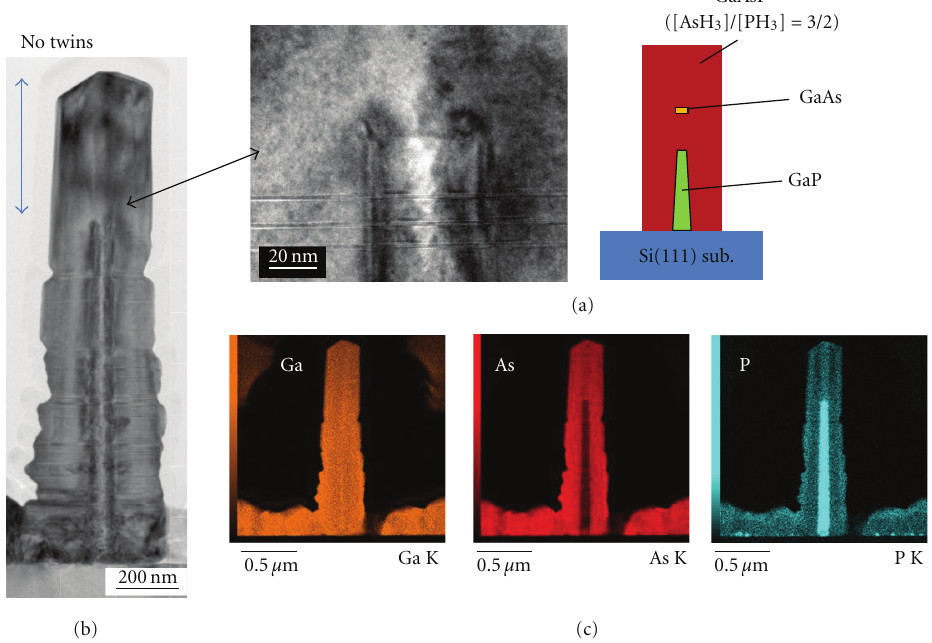
Figure 7: GaAsP nanopillar containing a GaAs dot. (a) Schematic illustration; (b) TEM images; (c) EDS mapping images. Here, an Au colloid with 60-nm diameter was used. The sample was thinned by the focused ion beam method. A stacking-fault-free region is confirmed above the GaP nanowire. However, we could not observe the dot in the